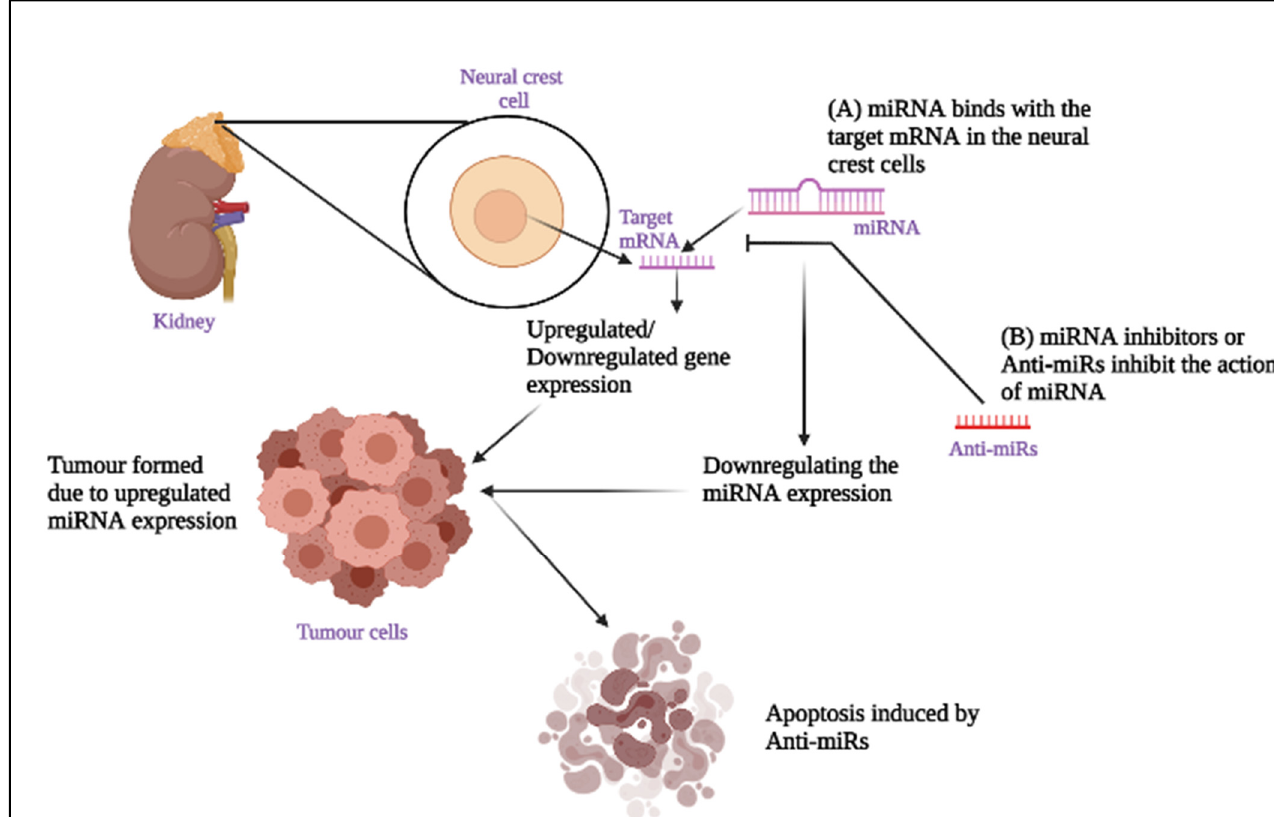
Figure 1. Role of miRNAs and miRNA inhibitor in Neuroblastoma: ( A ) MicroRNAs (miRNAs) with the RISC complex bind to the target mRNAs in the neural crest cells, thus leading to down-regulation or up-regulation of the target gene expression, which leads to a tumour. ( B ) Anti-miRs prevent the action of miRNAs by inhibiting the miRNAs from binding with target mRNA so that down-regulating the miRNA expression leads to apoptosis of the tumour cells.